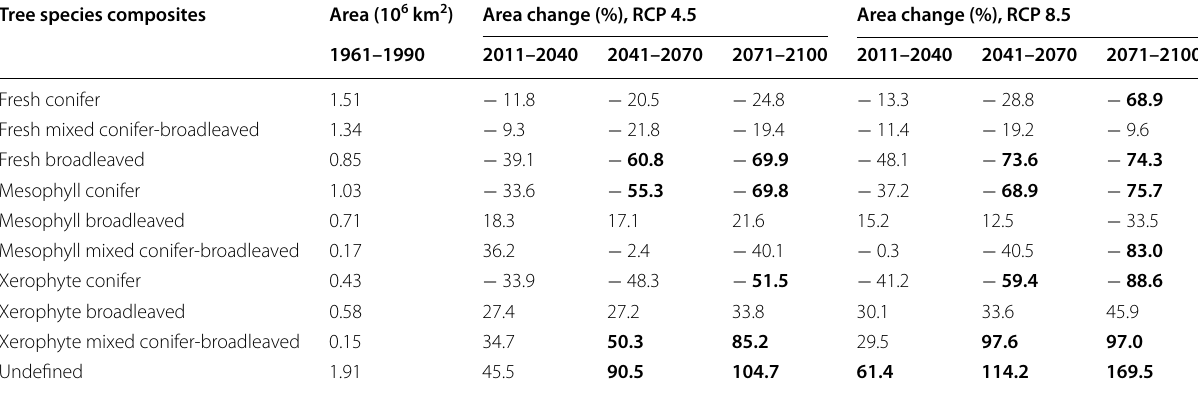
Area loss and gain > 50% in bold